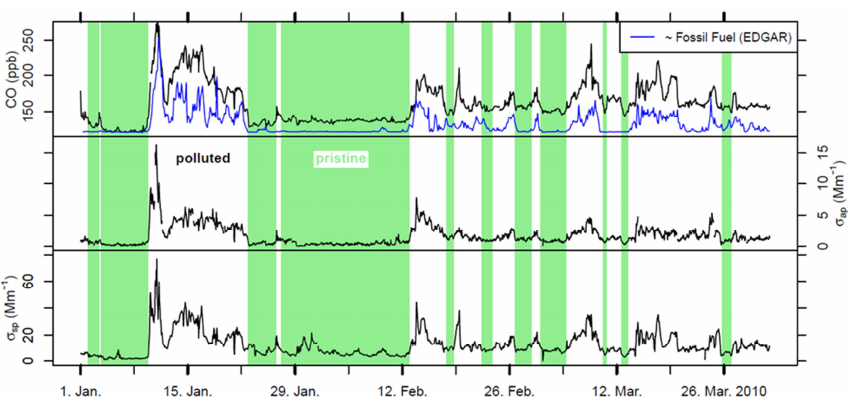
Figure 2 Example of separation of polluted air periods from pristine conditions. Measured CO concentrations, absorption coefficients, and scattering coefficients during winter 2010 are shown in the upper, middle, and lower figure respectively, and the STILT-model-estimated fossil fuel burning CO is shown in the upper figure in blue.